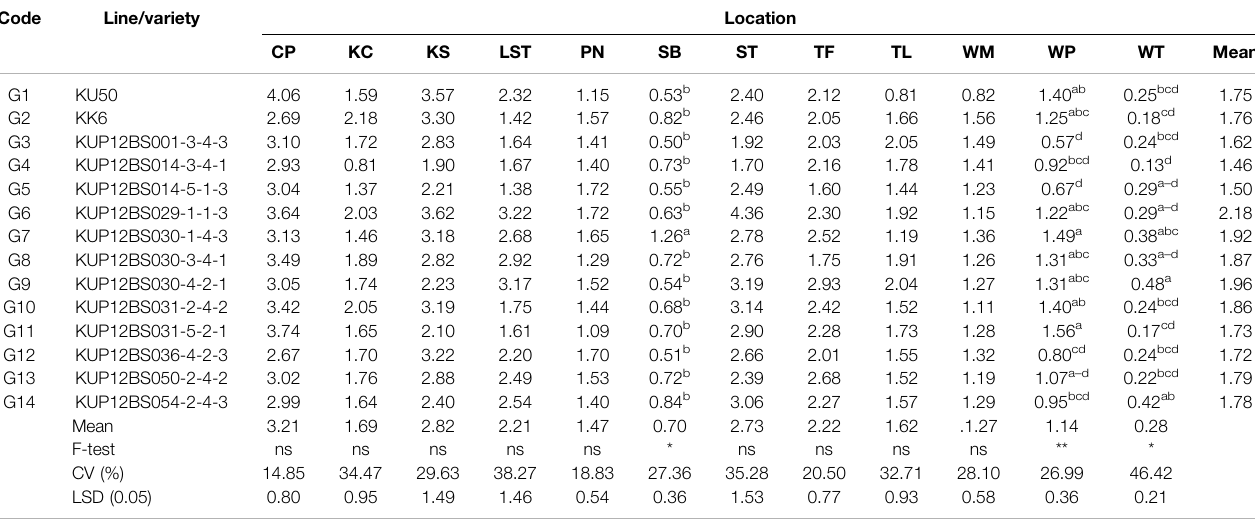
Code Line/variety